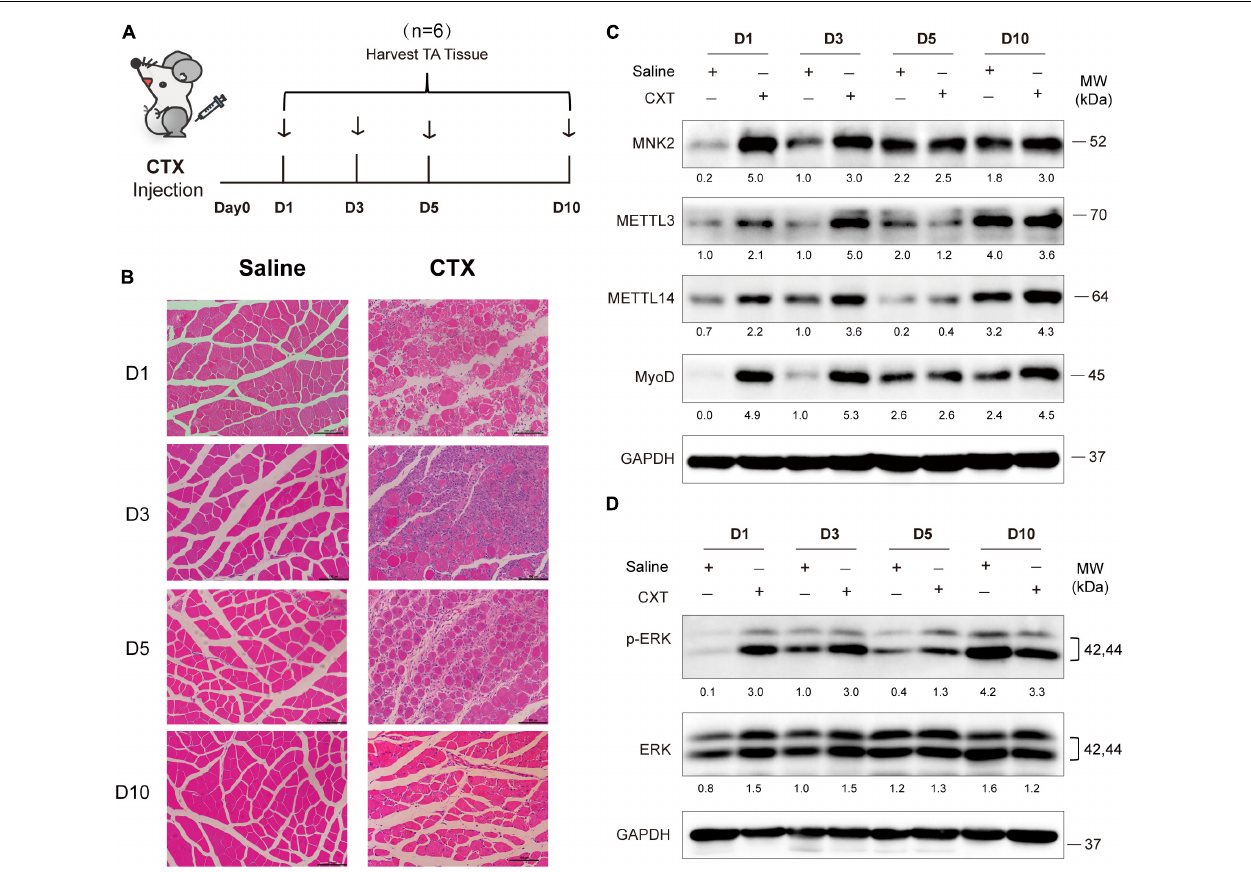
FIGURE 6 | METTL3/14 are ectopically expressed during acute skeletal muscle injury, and METTL3/14-MNK2-ERK might facilitate the early stage of skeletal muscle regeneration. (A) Time points of mice tibialis anterior (TA) muscles injection with CTX and collected tissues on day1 (D1), day3 (D3), day5 (D5), and day10 (D10). (B) Hematoxylin and eosin staining of regenerated muscle on indicated recover time points. (C) Western blot assay of MNK2, METTL3, METTL14 and MyoD in regenerated muscle on indicated recover time points. (D) Western blot assay of p-ERK and ERK in regenerated muscle on indicated recover time